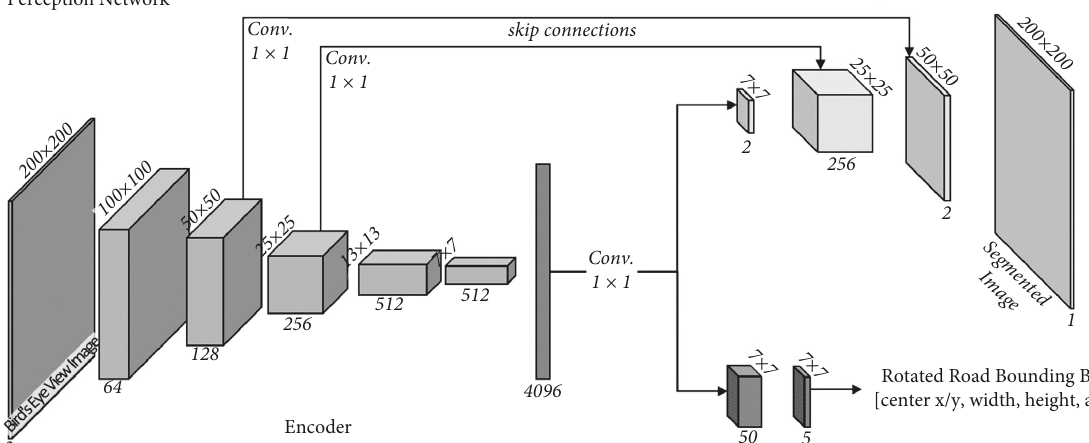
Figure 3: Multi-task perception deep neural network for intersection